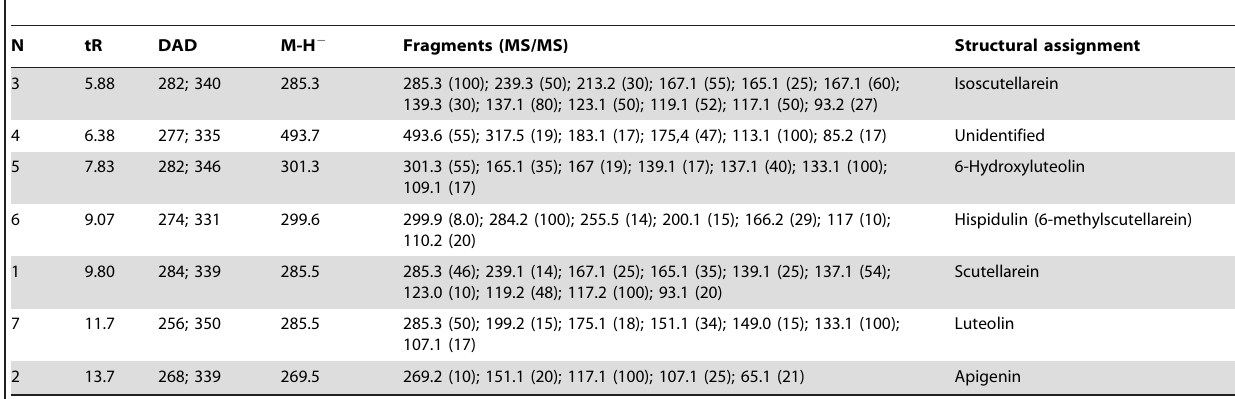
Table 1. LC–DAD–ESI-MS/MS identification of the major constituents of Arrabidaea chica (AC)